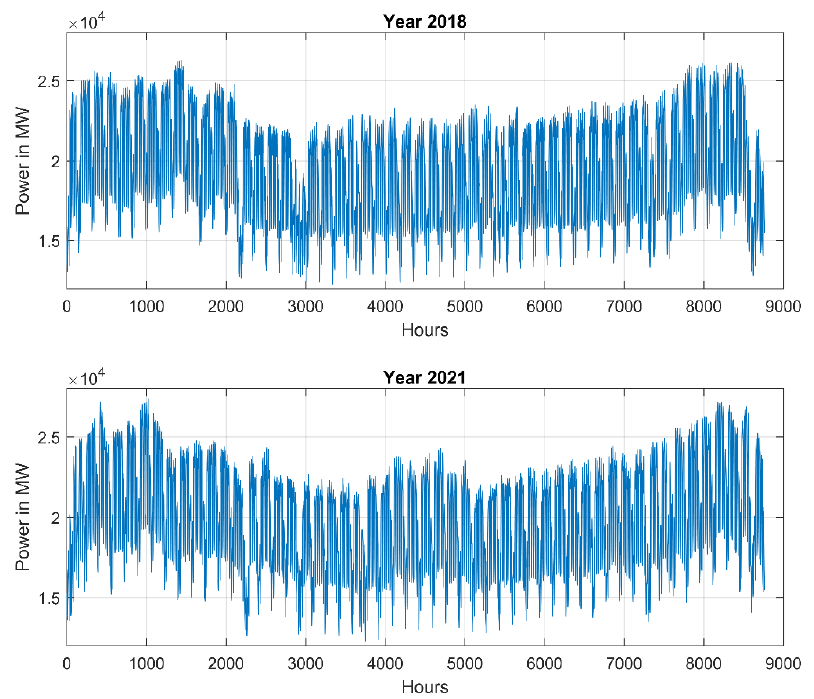
Figure 2. The hourly patterns of power demand in the Polish Power System for 2 years: 2018 and